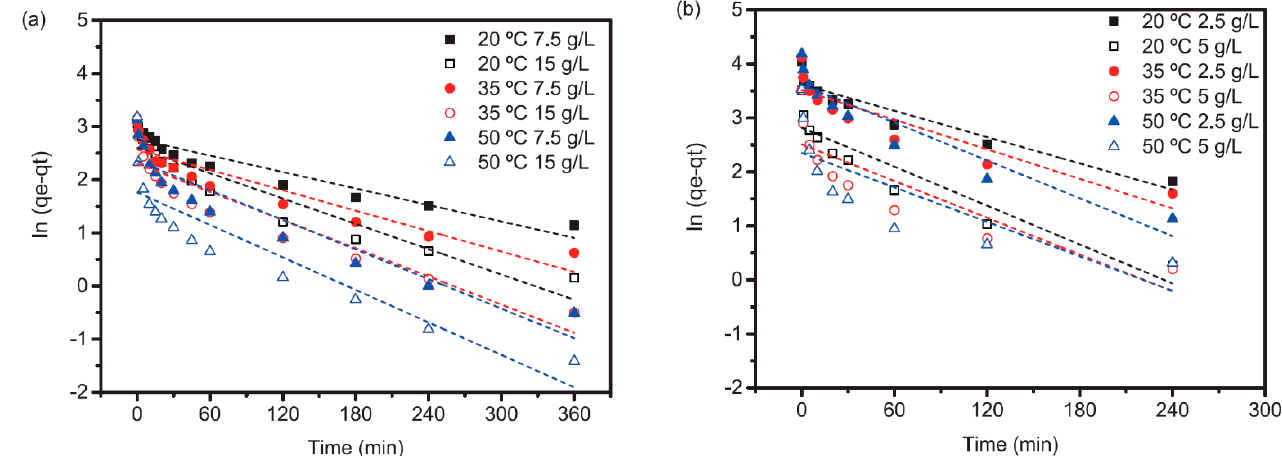
Figure 6. Lagergren’s pseudo-first-order rate fit for ( a ) pseudoboehmite ( b ) γ -Al 2 O 3 (experimental conditions: initial pH 8.5, dosages and temperatures in the legend).